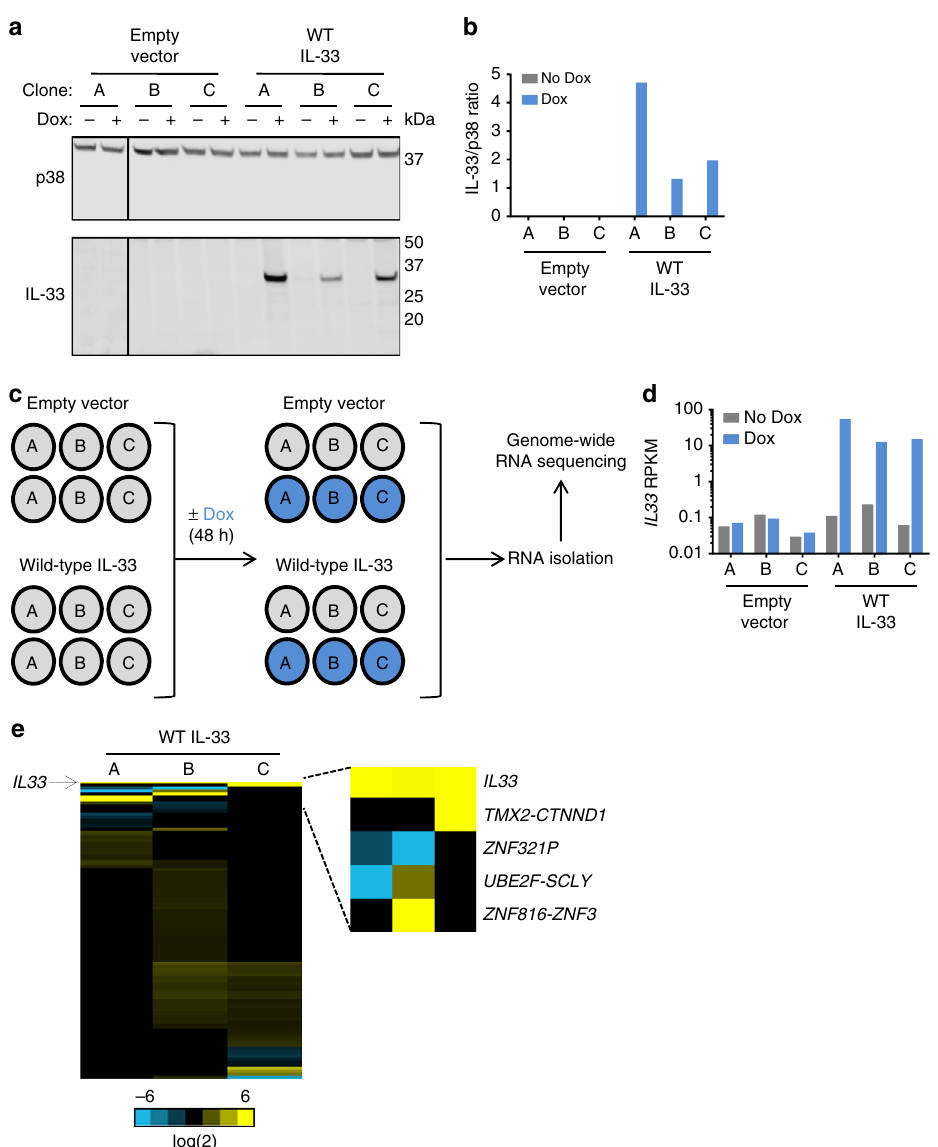
Fig. 1 Nuclear IL-33 does not impact gene expression. a Western blot analysis of IL-33 protein expression, with quanti fi cation in b , in indicated single-cell clones of TE-7 cells with stable, doxycycline (Dox)-inducible expression of wild-type (WT) IL-33 or the empty vector with or without treatment for 48 h with Dox. Total p38 was used as a loading control. c TE-7 single-cell clones from a were treated with Dox for 48 h, and then RNA was isolated and subjected to genome-wide RNA sequencing (RNA-seq) analysis. d IL33 RPKM levels in samples subjected to RNA-seq in c . e Heatmap of fold change in expression in each single-cell clone overexpressing WT IL-33 of genes with statistically signi fi cant differential expression in at least one clone. Differentially expressed genes (DEG) were identi fi ed by fi ltering on RPKM ≥ 1, Benjamini – Hochberg false discovery rate (FDR) of 5%, and fold change (FC) ≥ 1.5. Depicted is the log 2 ratio of gene expression in cells treated with Dox compared to cells without Dox. In b and d , bars represent values of individual samples. IL,